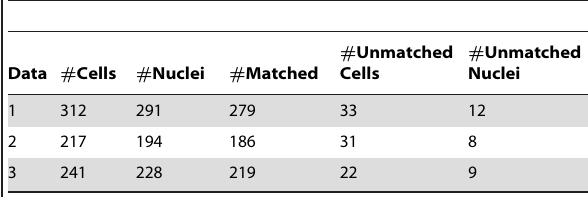
Detection and error rates of the automated algorithm was compared with standard nuclear segmentation algorithms. The assumption was that perfect segmentations of both algorithms should theoretically establish a one-to-one correspondence between nuclei and membranes detected. Matched refers to cells with membrane and nuclei in exact correspondence. Unmatched Cells refer to membranes that did not contain a unique nucleus. Unmatched Nuclei refer to nuclei that did not correspond to a cell membrane.